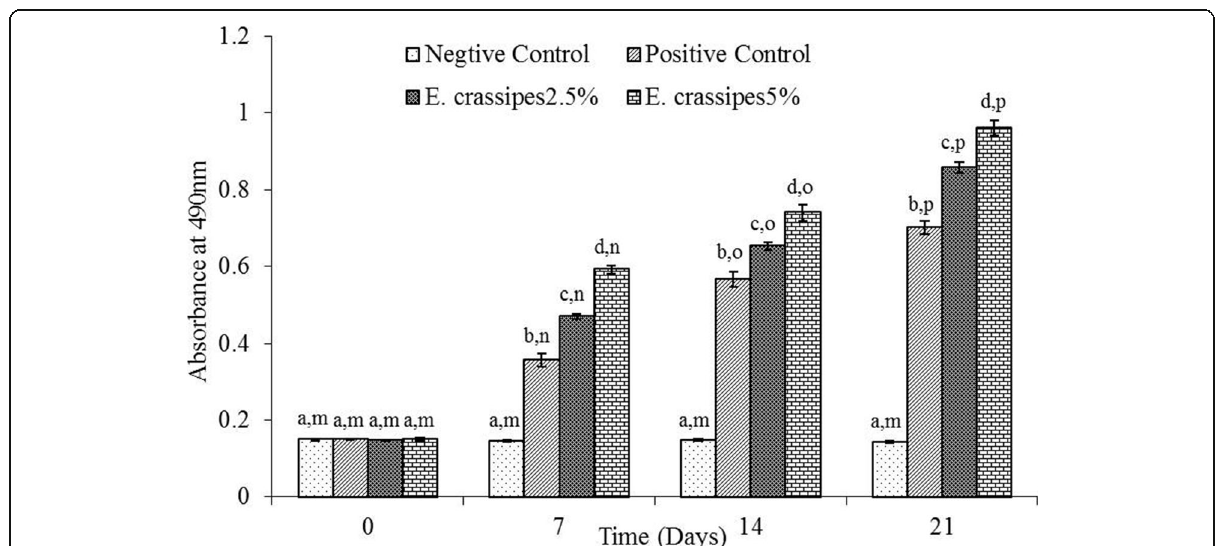
Fig. 5 Immunoglobulin levels in the serum of C. punctata at various time intervals (days 0, 7, 14, and 21). Values are expressed in mean ± SEM. p values were calculated using one-way ANOVA followed by Student Newman-Keuls ’ multiple range test, and p values ≤ 0.05 are statistically different. Error bars with dissimilar superscripts differ significantly. Values compared within four groups, specific time point is represented by superscripts “ a ” to “ d, ” and within groups at various time points is represented by superscripts “ m ” to “ p